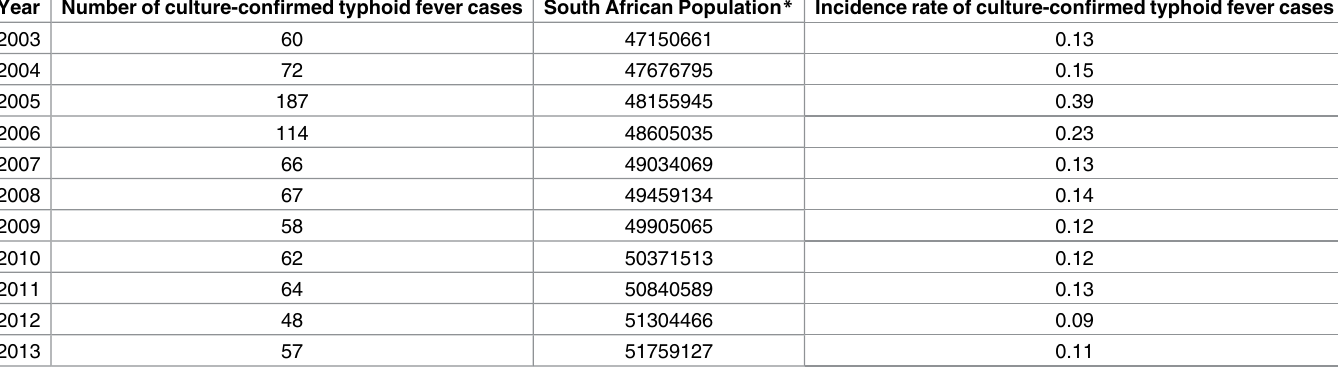
Table 1. Number of cases and incidence rates per 100,000 population of culture-confirmed typhoid fever cases in South Africa 2003–2013 (N = 855). Year Number of culture-confirmed typhoid fever cases South African Population * Incidence rate of culture-confirmed typhoid fever